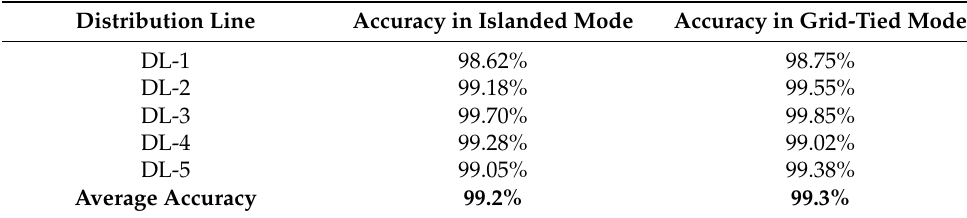
Table 4. Fault classification accuracy of the proposed FIPS on the IEC MG system.